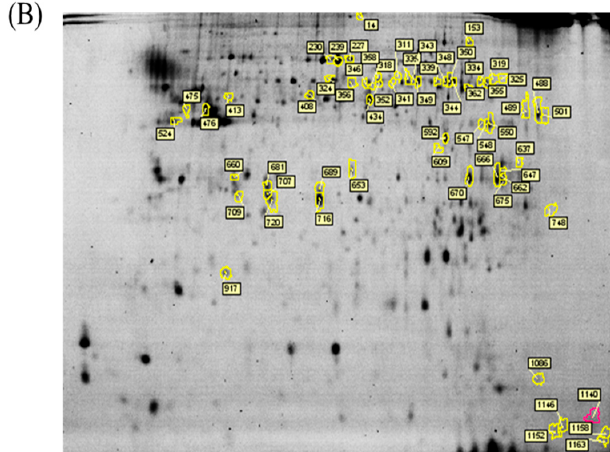
Figure 4. Comparison of proteomics between the IR injury and control groups in sclera. ( A ) Schematic representation of the 2D-DIGE workflow for monitoring the differentially expressed proteins in the sclera of the IR injury and control groups; ( B ) 2D-DIGE images of the tissue samples analyzed using DeCyder software; the differentially expressed identified protein features are annotated with circles and spot numbers.